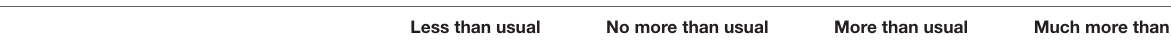
TABLE 1 | Chalder fatigue scale (Chalder et al.,